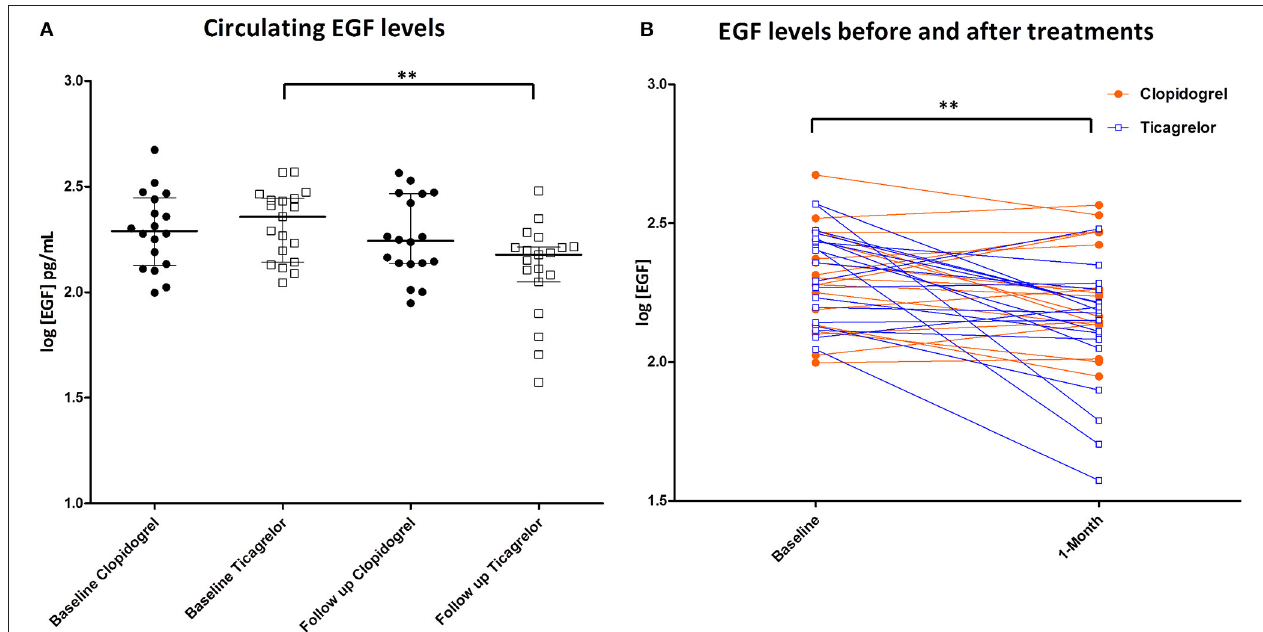
FIGURE 1 | (A) EGF levels in the serum of patients at baseline and after 1 month of treatment. Black circle: patient randomized to clopidogrel. White square: patient randomized to ticagrelor. ** P < 0.01; (B) EGF levels of patients representation before and after treatments. Orange circle: patient randomized to clopidogrel. Blue squares: patient randomized to ticagrelor. ** P < 0.01.